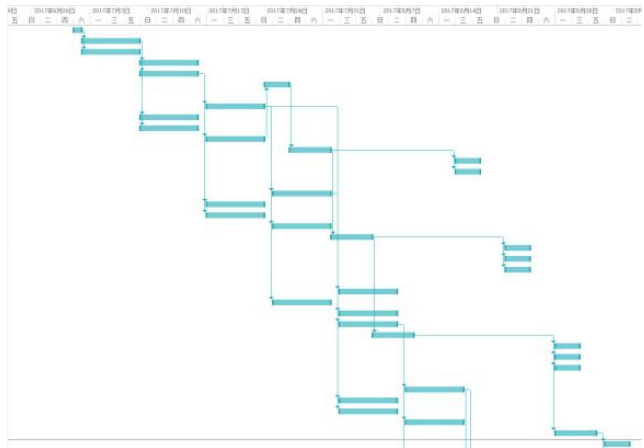
Figure 13. Construction schedule of the student dormitory building.